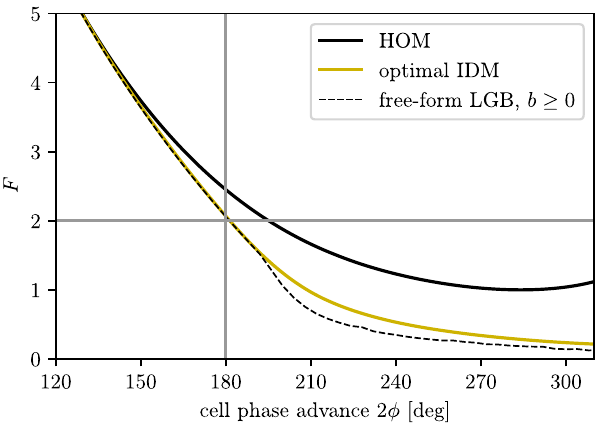
FIG. 7. Comparison of minimum possible emittances for HOM cells, optimized LGB cells with positive curvature, and IDM